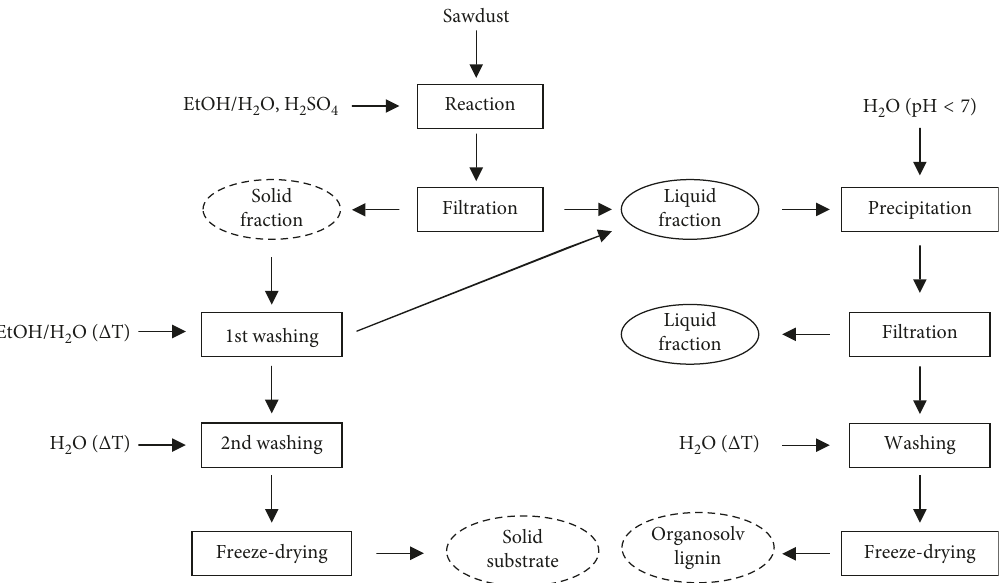
Figure 1: Schematic drawing of the organosolv fractionation and workup procedure. Product fractions are written in bold, dashed lines indicate solid fractions, whereas solid lines indicate liquid fractions.